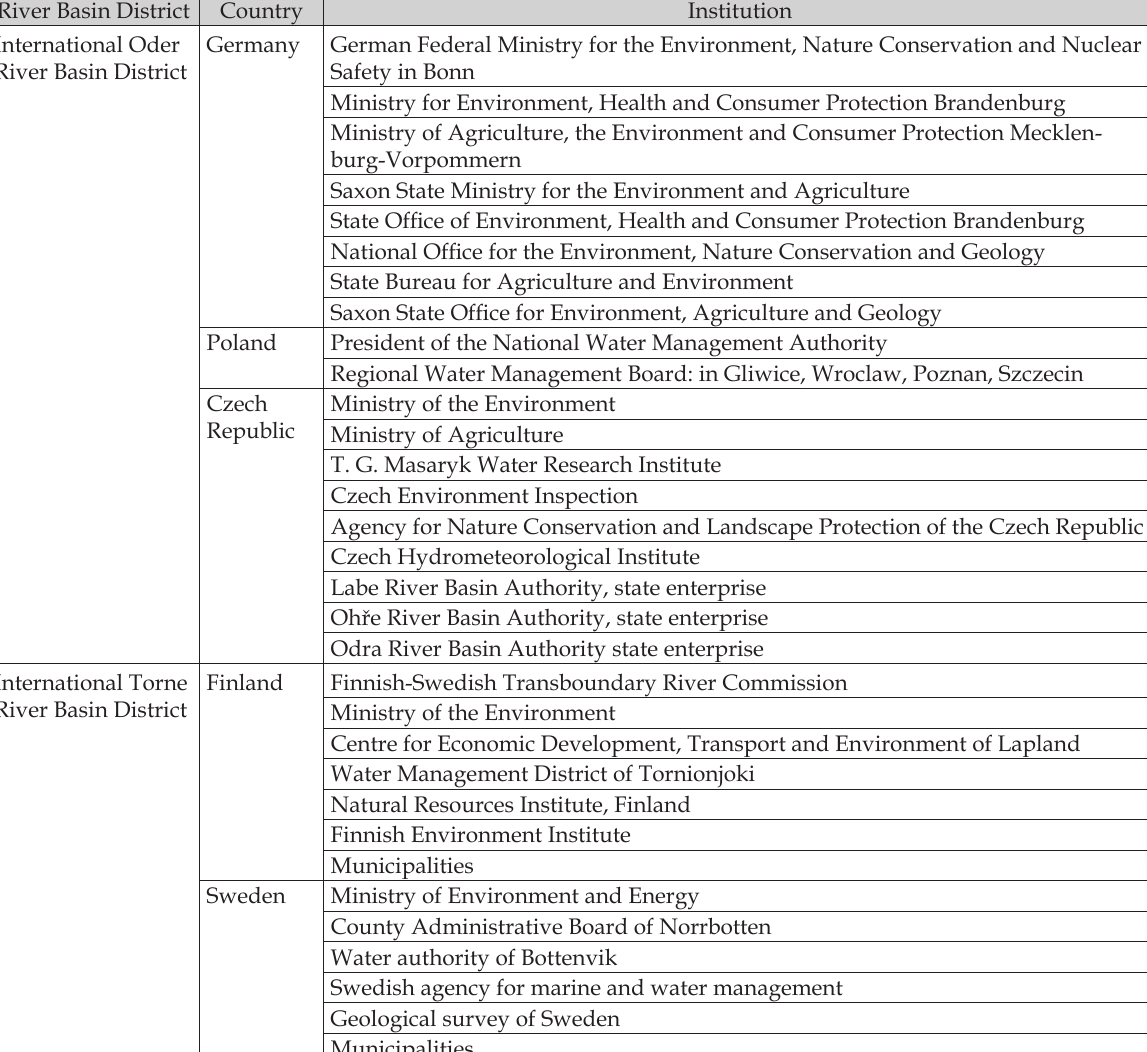
Table 2. Stakeholders on the area of the International Oder River Basin District (IORBD) and the International Torne River Basin District